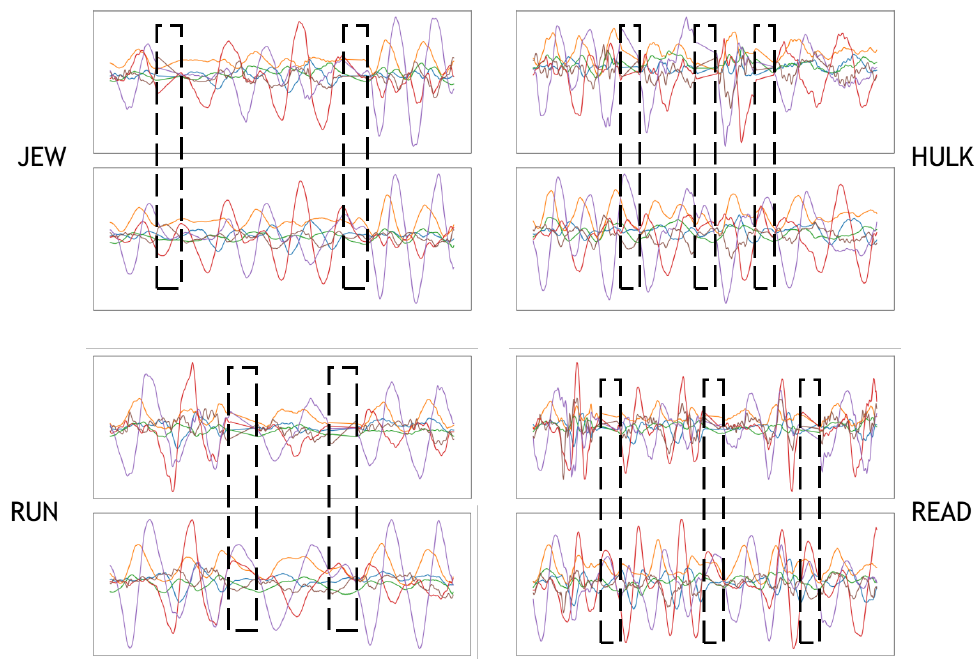
Figure 8. Outputs of the splicing module and generating module. There are two sample outputs for each word: The upper one is the wave of the spliced sample, and the lower one is the wave of the synthesized sample.